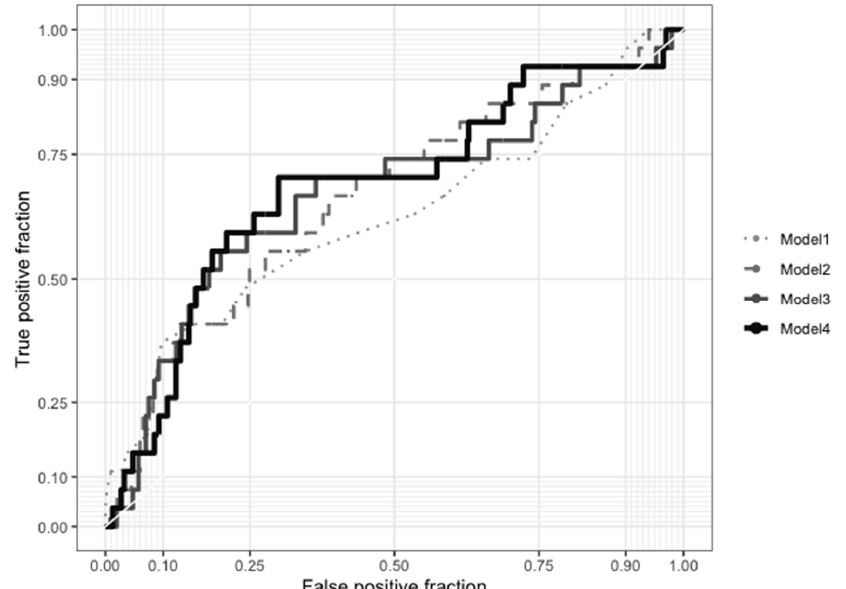
Figure 2. Receiver operating characteristic (ROC) curves for prediction of the primary composite endpoint. Model 1: Framingham risk score (FRS) alone, Model 2: fasting brain-derived neurotrophic factor (BDNF) + FRS, Model 3: BDNF at 30 min + FRS, and Model 4: area under the curve of BDNF + FRS. The area under the ROC curve was 0.61 (95% CI: 0.52–0.73) for Model 1, 0.65 (95% CI: 0.55–0.75) for Model 2, 0.70 (95% CI: 0.61–0.79) for Model 3, and 0.72 (95% CI: 0.63–0.81) for Model 4. The C index showed that compared with Model 1, Models 4 and 3 had significantly greater predictive power ( p = 0.016 and 0.038, respectively), but not Model 2 ( p = 0.160). Table 2. Total integrated discrimination index (IDI) and net reclassification index (NRI) for adding fasting brain-derived neurotrophic factor (BDNF), BDNF at 30 min, and area under the curve (AUC) of BDNF to Framingham risk score (FRS) to predict the cardiovascular events. Model